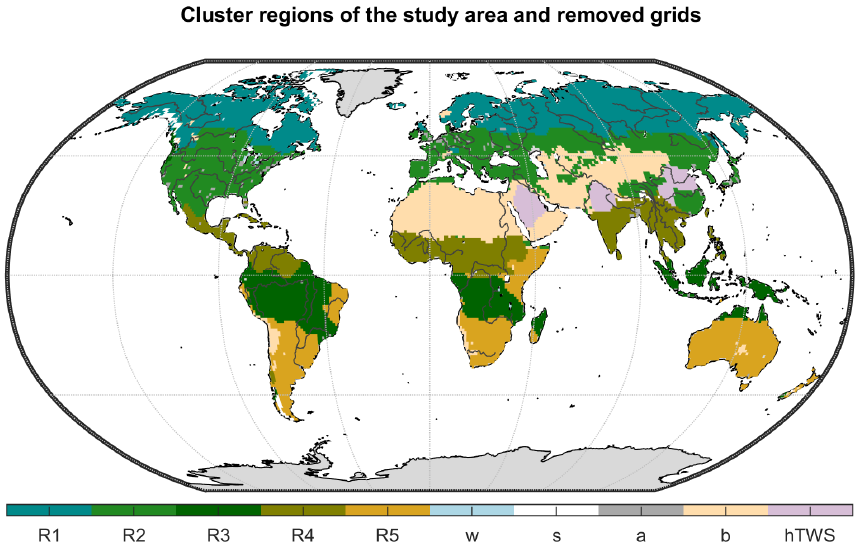
Figure 2. Hydroclimatic cluster regions of the study area (R1 – cold, R2 – temperate, R3 – humid, R4 – sub-humid, R5 – semi-arid) and grid cells that have been excluded from this study ( w is the water fraction > 50%, s the permanent snow and ice cover > 10%, a the artificial land cover fraction > 10%, b the bare land surface > 20%, and hTWS the direct human impact on the trend in GRACE